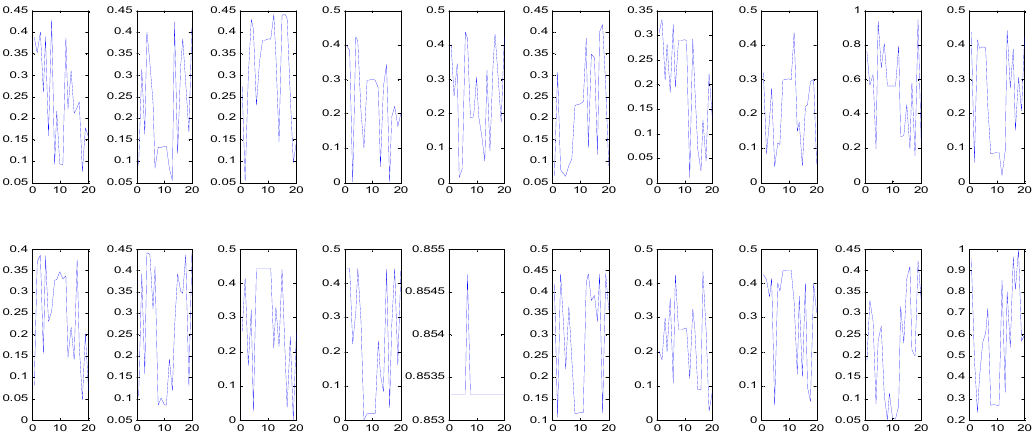
Figure 7. The changing curve between the causes’ membership degree (Y-axis) and k (X-axis) obtained by GA.